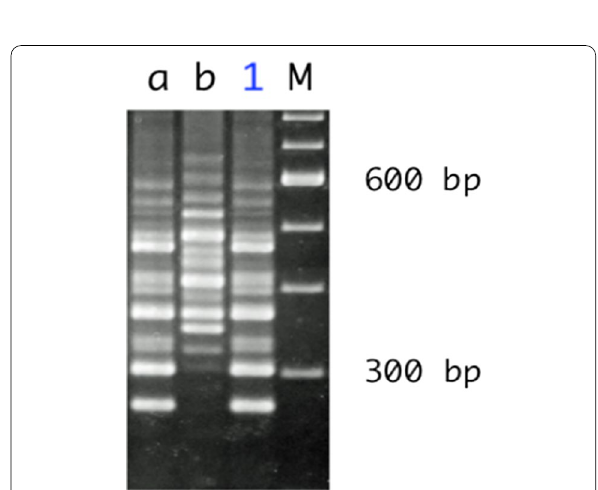
Fig. 5 PCR-ribotype pattern of the isolate recovered from the present case. Lane M, 100-bp ladder as a DNA size marker; lane 1, the isolate from our case; lane a, ribotype 027; lane b, ribotype